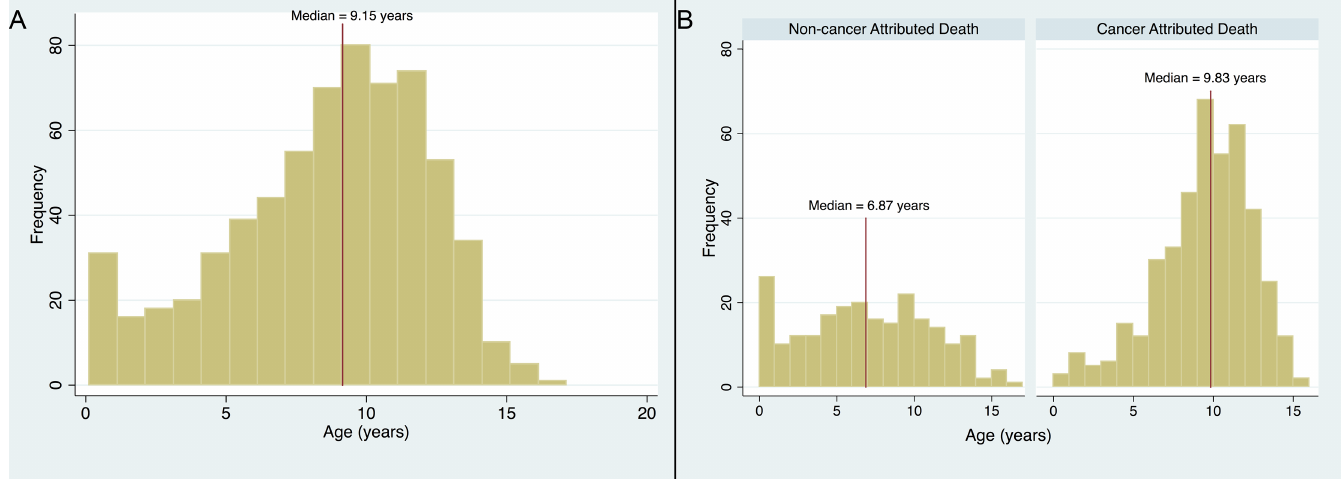
Fig 4. Age distribution of golden retriever dogs. (A) Histogram of age for all golden retriever dogs undergoing a necropsy exam with a median age of 9.15 years. (B) Histogram of ages of all golden retriever dogs undergoing a necropsy exam categorized by having a death attributable to cancer or not with a median age of death for those dogs dying of non-cancerous cause of 6.87 years and a median age of death of 9.83 years for those dogs with a cancer attributable death.